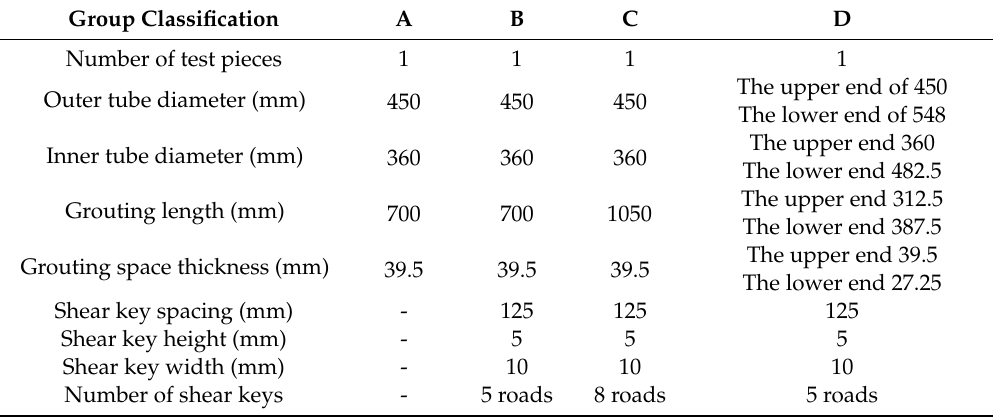
Table 3. Parameters of the